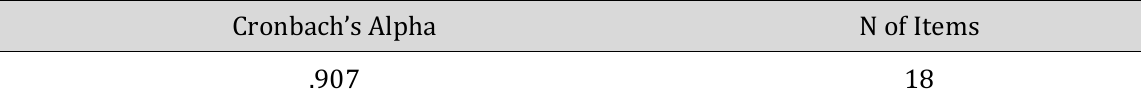
Table 8. reliability test results for the teacher’s oral feedback variable.